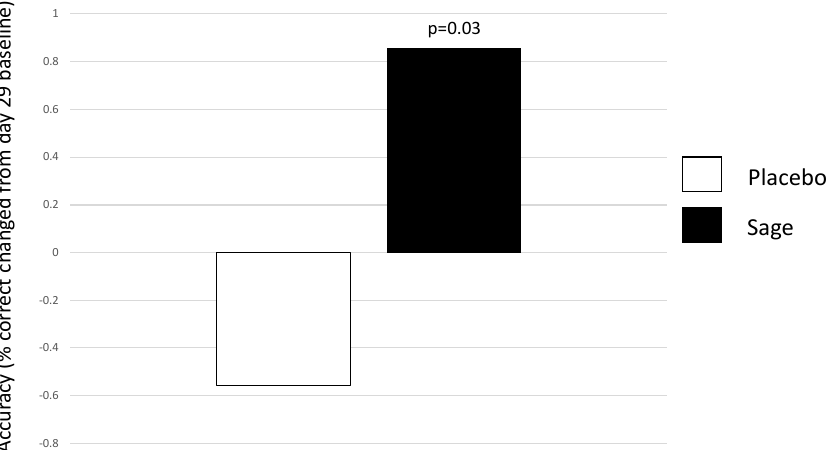
Figure 6. Acute main effect of treatment on day 29 on numeric working memory accuracy: a significant acute main effect of treatment was observed on day 29 ( p = 0.03). Here, percentage change from baseline (day 29 pre-dose) accuracy was higher in the sage condition than the